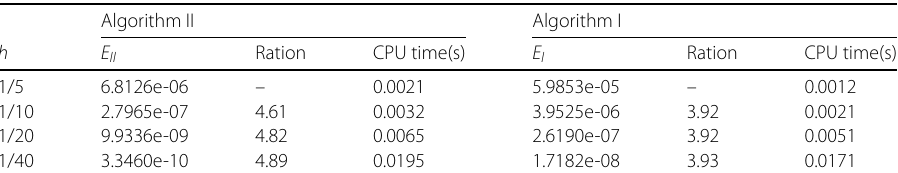
Table 2 The absolute errors of the presented algorithm I ( E I ) and algorithm II ( E II ) for (31) with α = 0.2, ν = 3.45